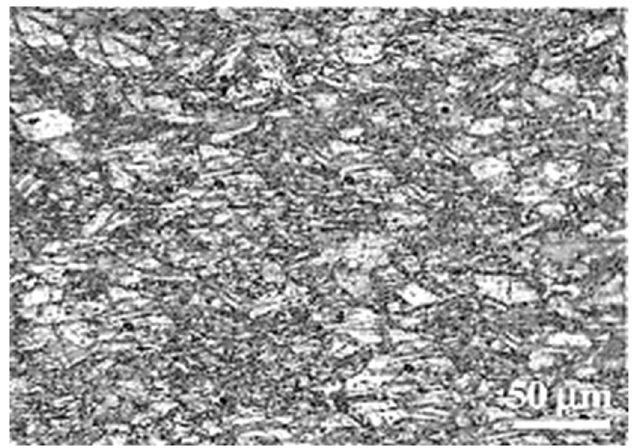
Figure A1. Optical image of microstructure of HAZ on retreating side. Table A1. Correlations between mechanical properties of FSW butt joint.